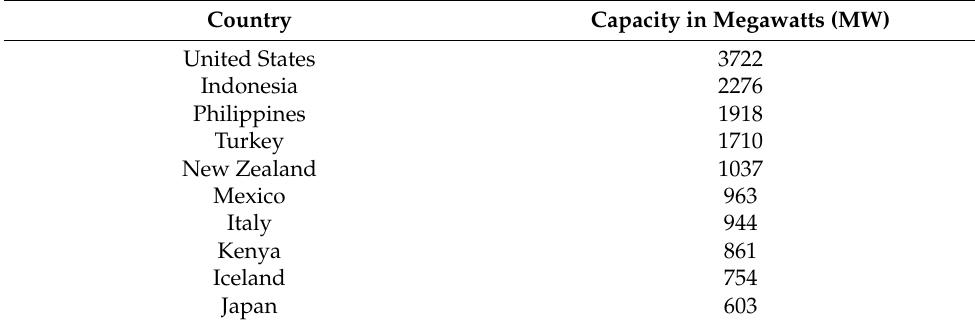
Table 1. Geothermal energy installation capacity for the top 10 countries in 2021. Country Capacity in Megawatts (MW) United